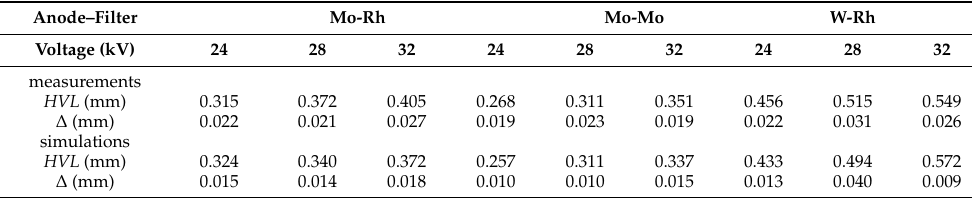
Table 4. Determined thicknesses of the Al half-value layer; ∆ , the expanded uncertainty of measure- ment/simulation for the 95% confidence